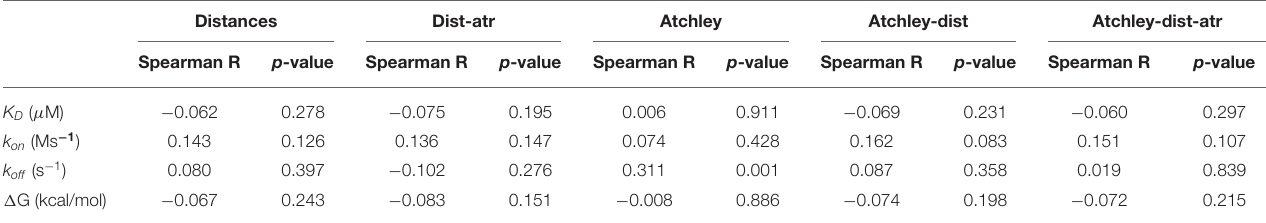
TABLE 3 | Correlations of affinity metrics and decision function scores. Distances Dist-atr Atchley Atchley-dist